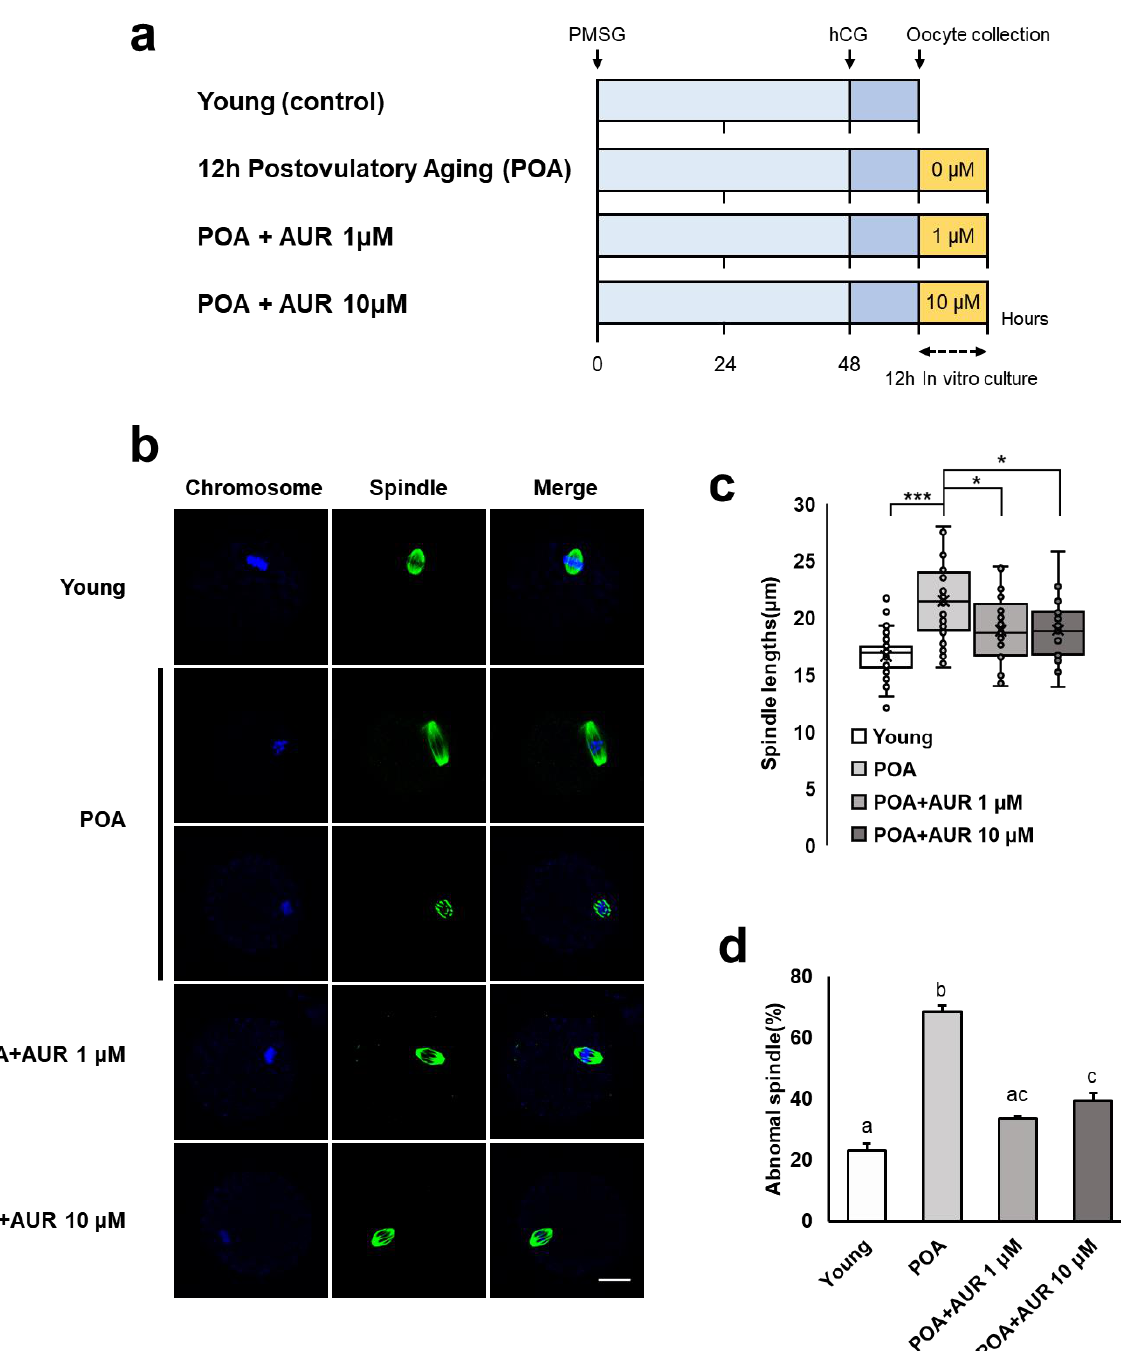
Figure 1. AUR protected the organizational dynamics of spindles and chromosomes during postovulatory aging. ( a ) A schematic diagram to illustrate the experimental design to investigate how AUR impact postovulatory aged oocytes. ( b ) Representative images of meiotic spindles and chromosomes in young and aged oocytes with or without AUR administration. Spindles were stained with α -tubulin (a spindle marker, green), and chromosomes were stained with DAPI (DNA, blue); scale bar = 20 μm. ( c ) Lengths of the spindles in each group of oocytes. Dots of boxplot show individual values of each observation. ( d ) Percentages of abnormal spindles in oocytes in each group. Data are presented as the means ± SEMs of at least three independent experiments. Significant difference indicated by lowercase letters of the alphabet, p < 0.05, * p < 0.05, *** p < 0.001.